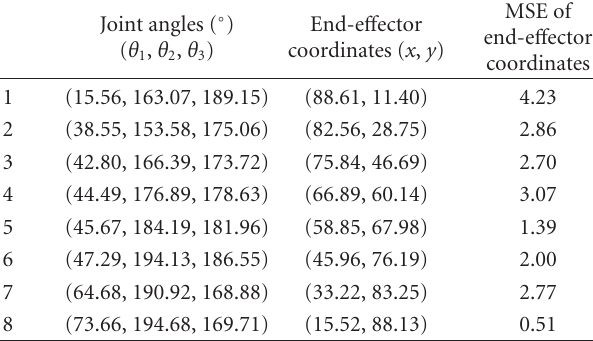
Table 2: Estimated joint angles, calculated end-e ff ecter coordinates, and mean square errors for well-posed